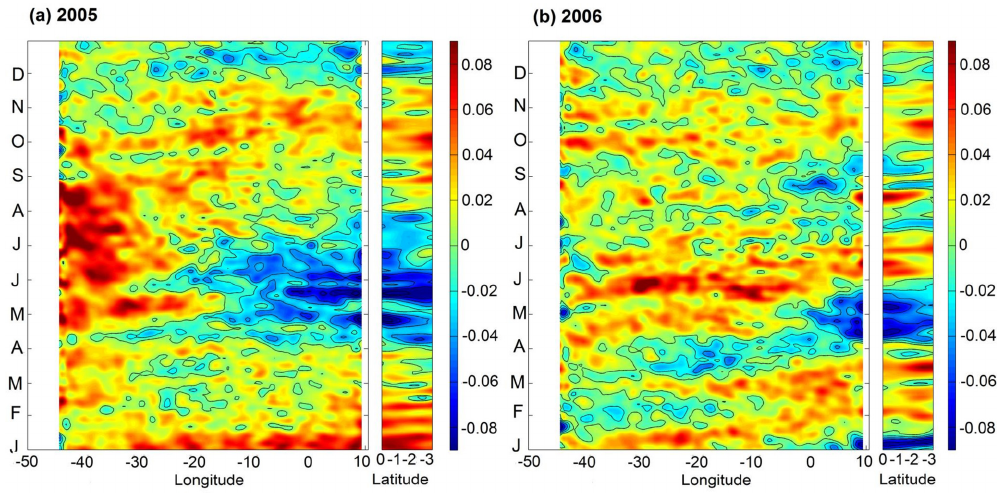
Figure 6. Time evolution of the sea level anomaly (m) along the Equator (between 54 ◦ W and 12 ◦ E) and along 9 ◦ E (between the Equator and 3 ◦ S) for 2005 (a) and 2006 (b) from AVISO